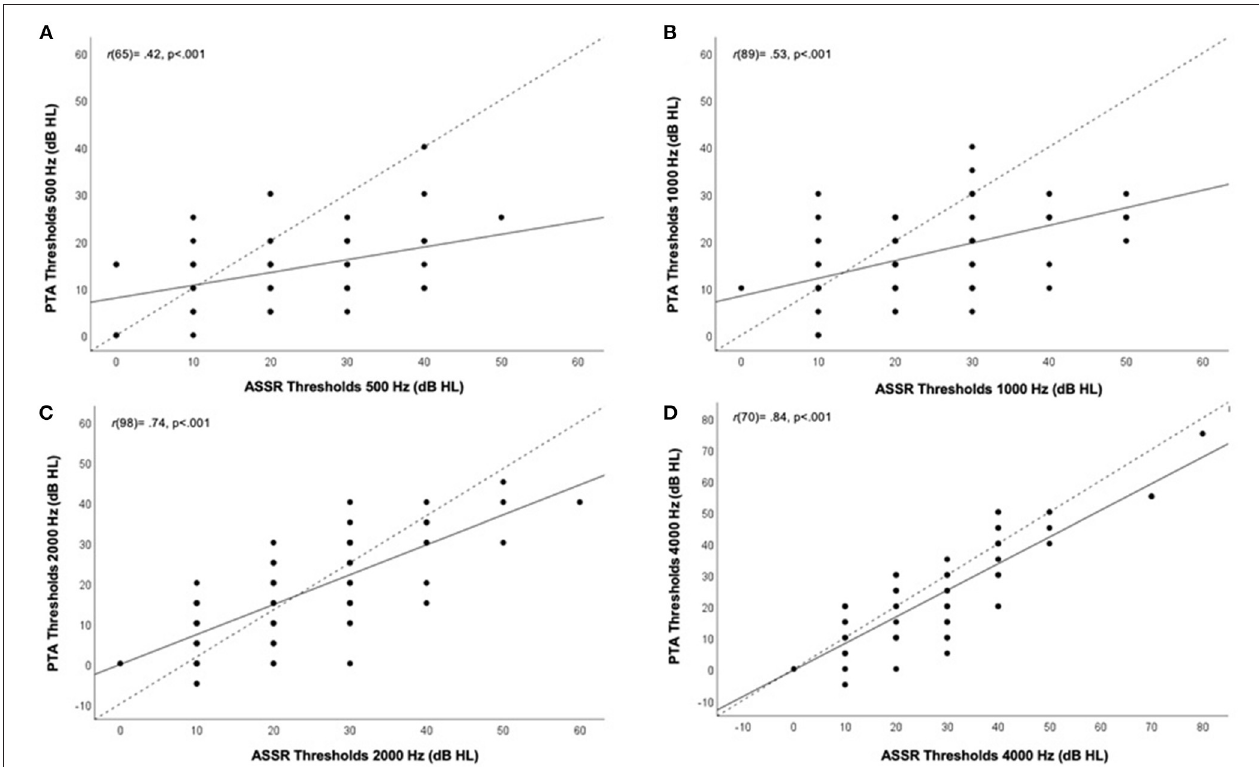
FIGURE 4 | Correlation between hearing thresholds (both ears combined) obtained from auditory steady-state response (ASSR) (x-axis) and pure-tone audiometry (PTA) (y-axis) in dB HL according to carrier frequency. Different panels show different frequencies. (A) 500Hz, (B) 1000 Hz, (C) 2000 Hz, and (D) 4000 Hz. Correlation coefficients (r) and p-value are presented on the top left corner of each panel for all tested frequencies. Black line indicates line of best fit, dotted line indicates 1:1 ratio